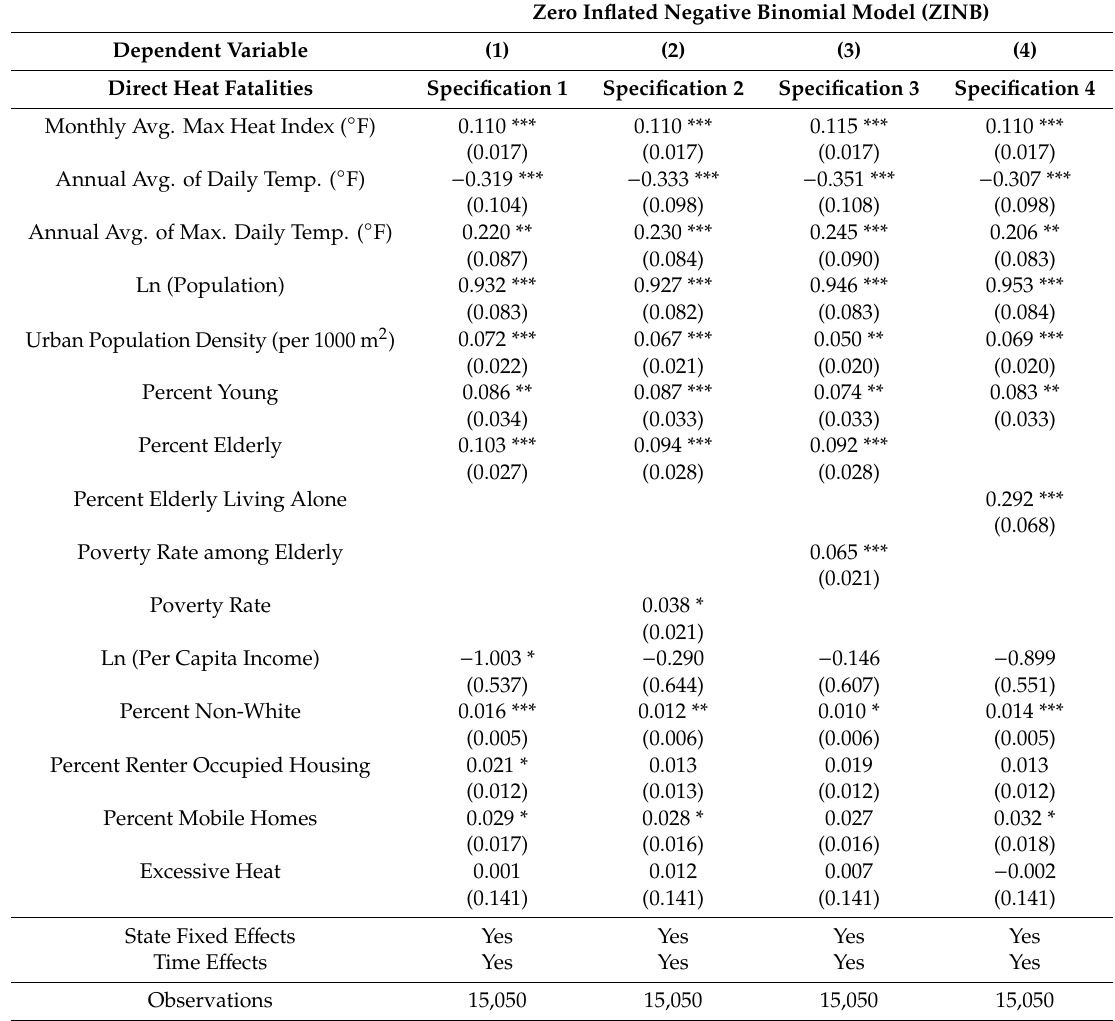
Table 7. Heat vulnerability—fatalities model zero-inflated negative binomial regression